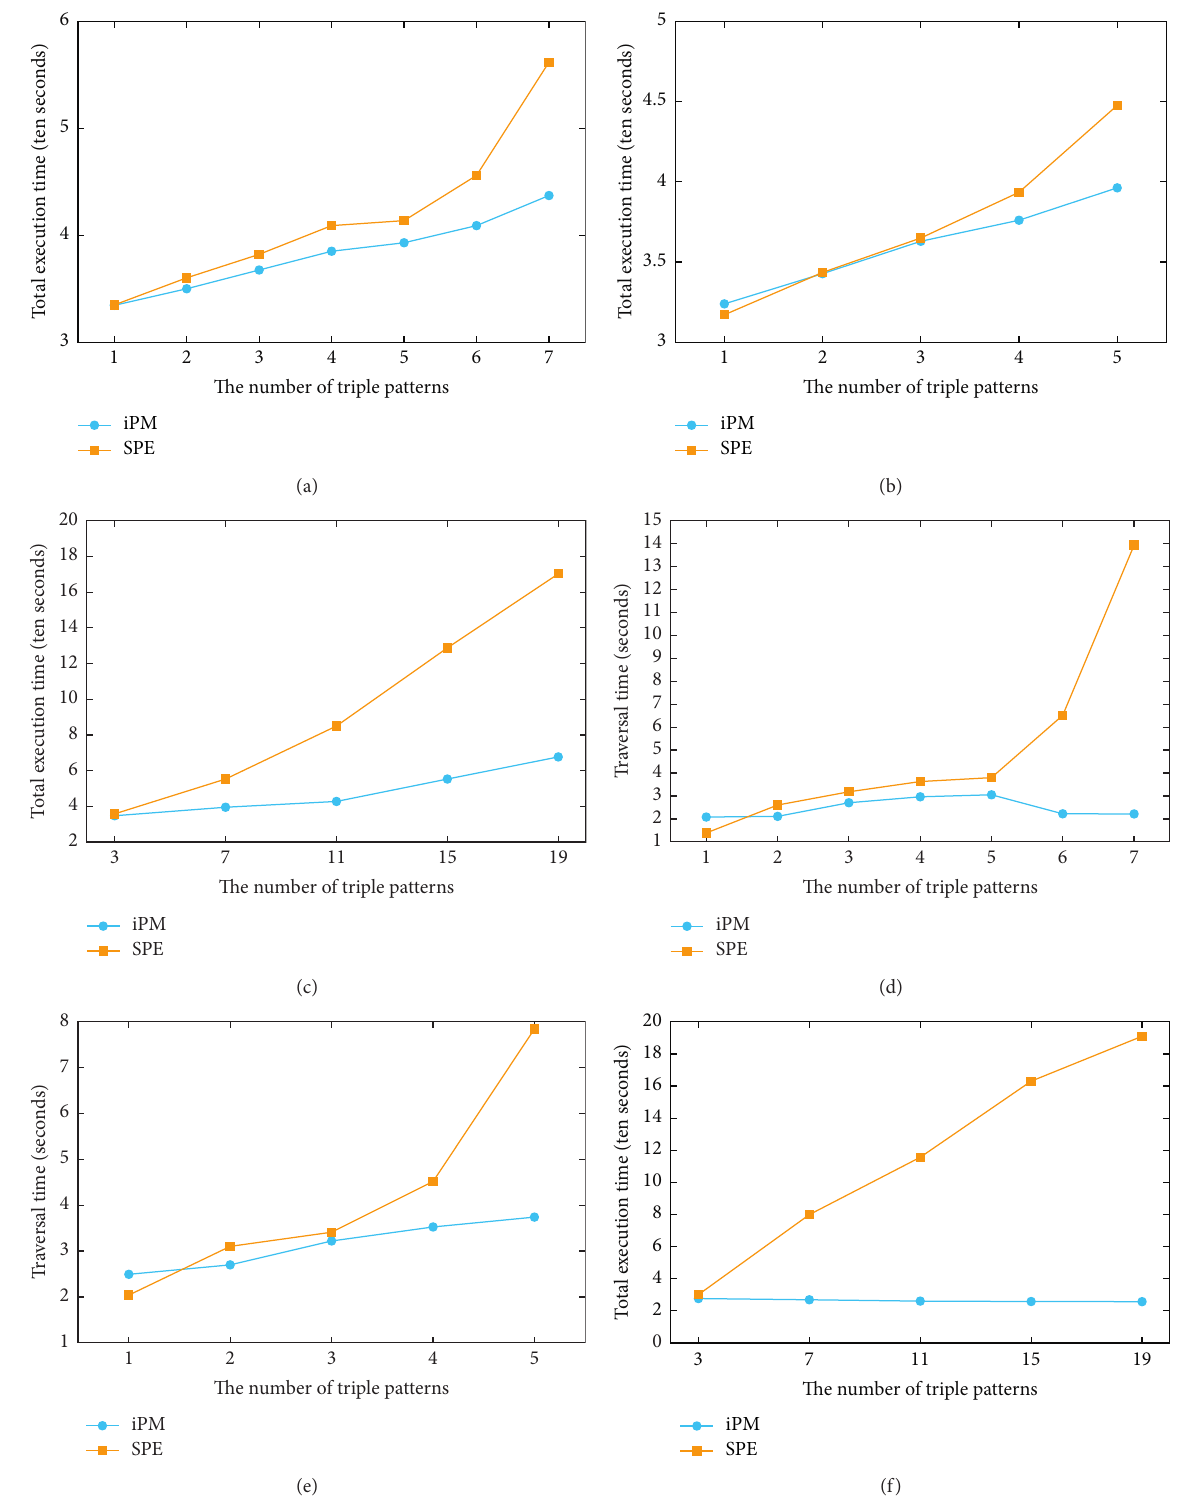
Figure 9: The performance evaluation on SNB dataset. (a) Total matching time of star query. (b) Total matching time of chain query. (c) Total matching time of cycle query. (d) Matching time of star query. (e) Matching time of chain query. (f) Matching time of cycle